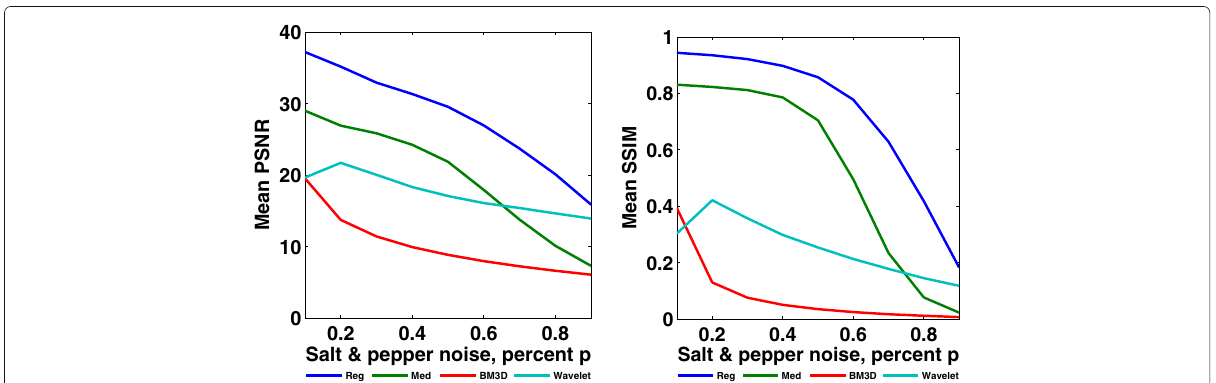
term of the noisy pixels in P ( i , j ) ’s radius d square neighborhood. Higher order terms significantly